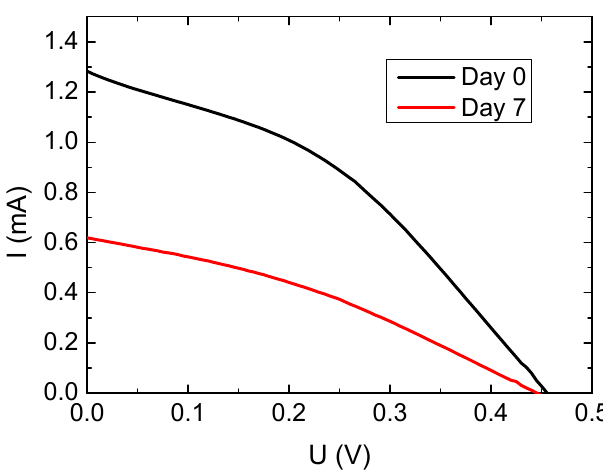
Figure 2. Current-voltage ( I - U ) characteristics of a glass-based DSSC, prepared with an anthocyanin-based dye.